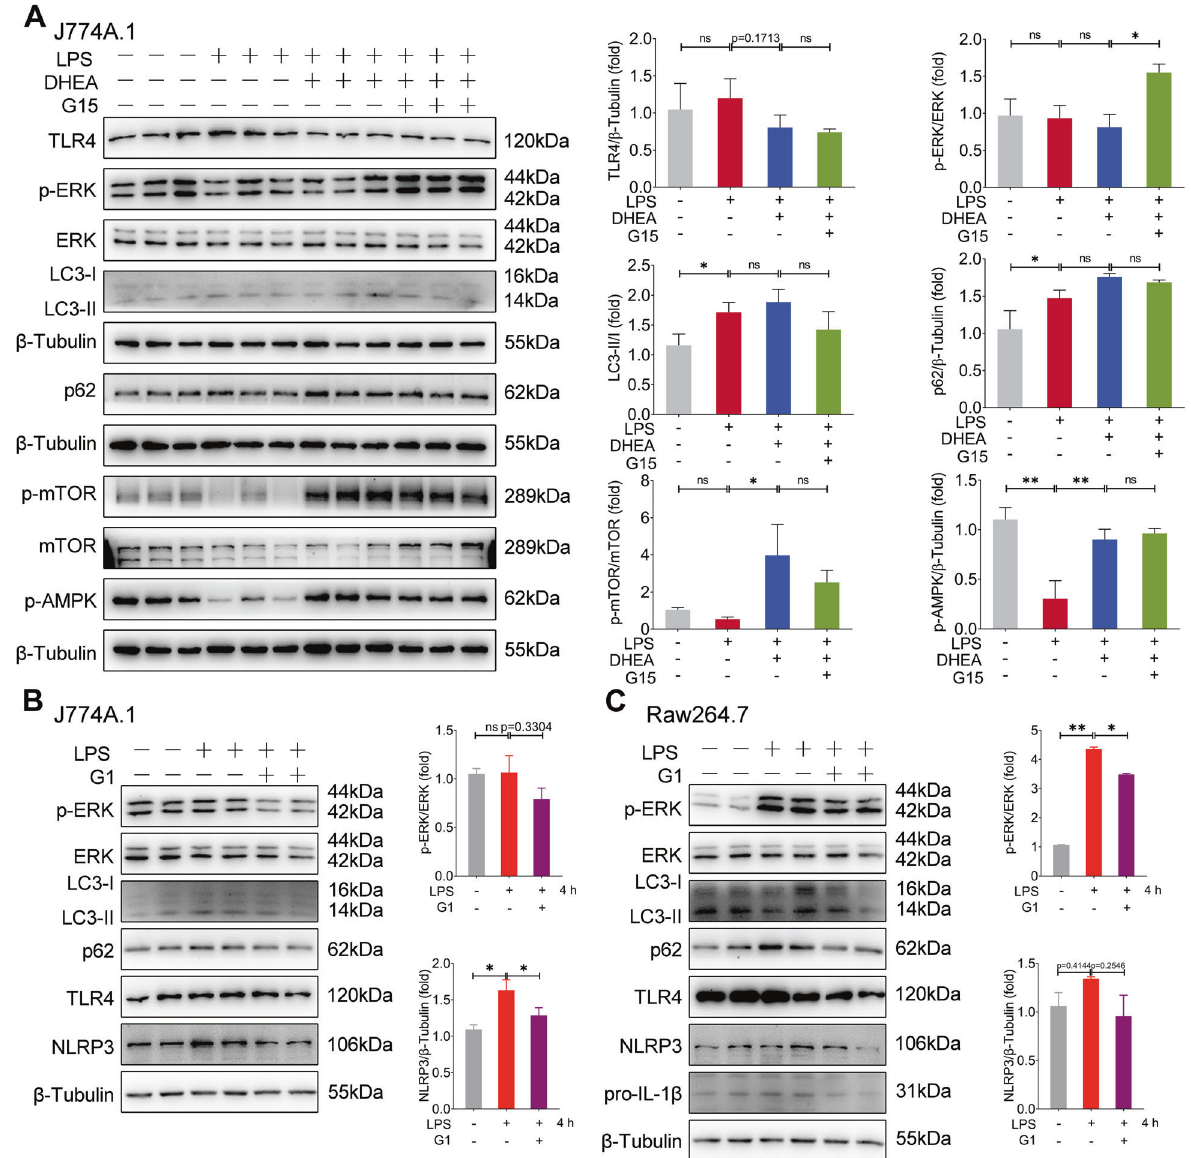
Fig. 4 DHEA activates GPER and AMPK/mTOR signal in in fl ammatory macrophages. A J774A.1 cells were pre-treated with DHEA (50 μ M) in the presence or absence of the GPER inhibitor G15 (1 μ M) for 1 h, then stimulated with LPS for 4 h. The TLR4, p-ERK/ERK, LC3, p62, p-mTOR, and p-AMPK protein expression levels were measured by western blotting and quanti fi ed by Image J software. B , C J774A.1 and RAW264.7 cells were pre-treated with G1 (1 μ M) for 1 h, then stimulated with LPS for 4 h, and the indicated protein expression levels were measured by western blotting and quanti fi ed by Image J software. Data are presented as means ± SEM ( n = 3 or 4). * P < 0.05, ** P < 0.01, compared with the respective